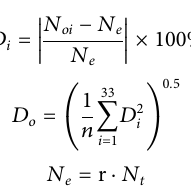
(Figure 1, white circle). The meteorological data from 1951 to 2013 were downloaded from the National Earth System Science Data Center, P.R.